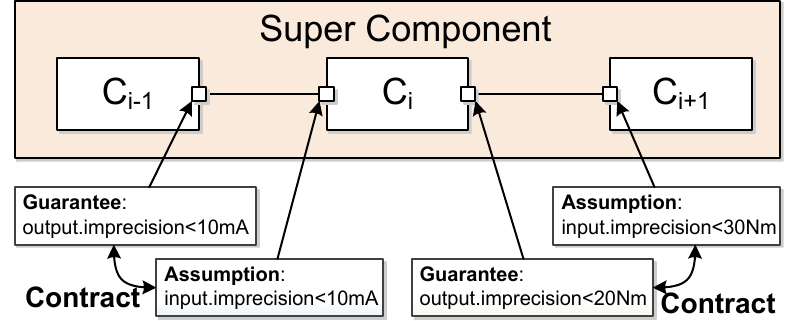
Figure 3. Signal quality example of interface